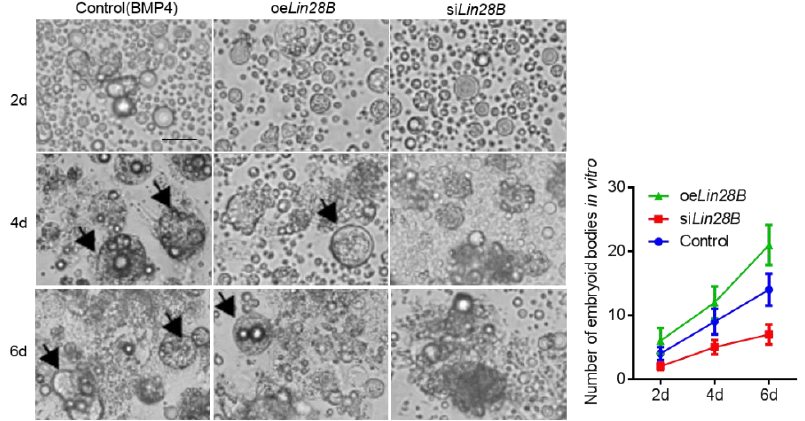
Figure 6. Observation ( Left ) and statistics ( Right ) of the number of EBs during induction after different treatments of Lin28B . Scale bar: 60 μm.